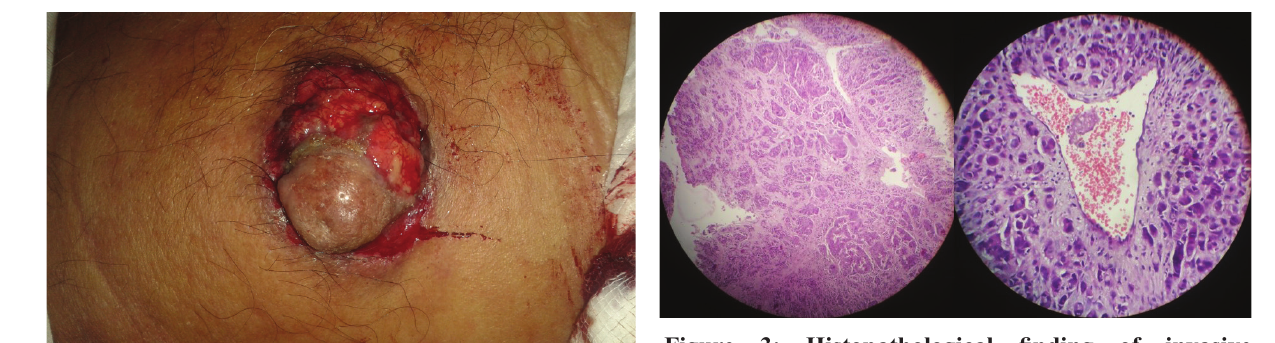
Figure 3: Histopathological finding of invasive carcinoma of no special type and vascular invasion